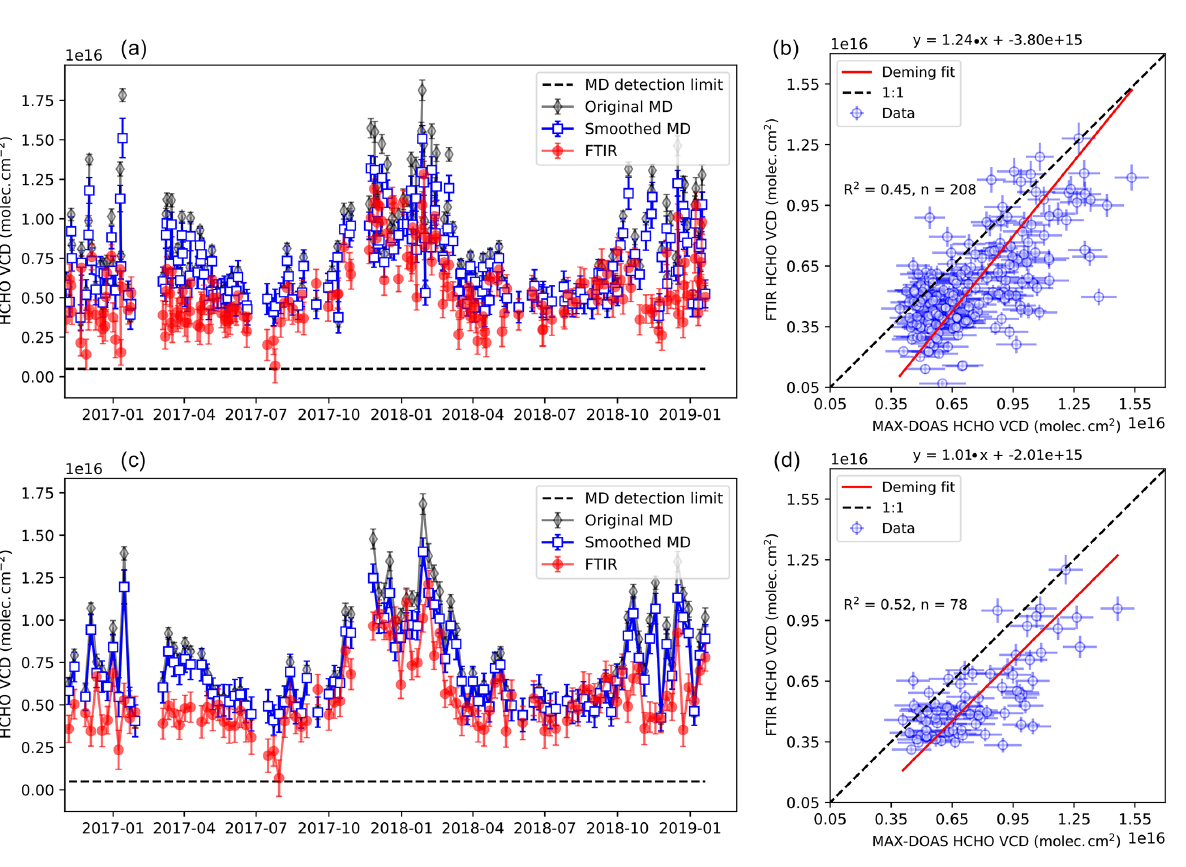
Figure A1. Results for the comparison of formaldehyde columns from FTIR and the MAX-DOAS (convolved with FTIR averaging kernels) at Lauder: (a) daily average time series, (b) daily average scatter plot, (c) weekly average time series and (d) weekly average scatter plot.